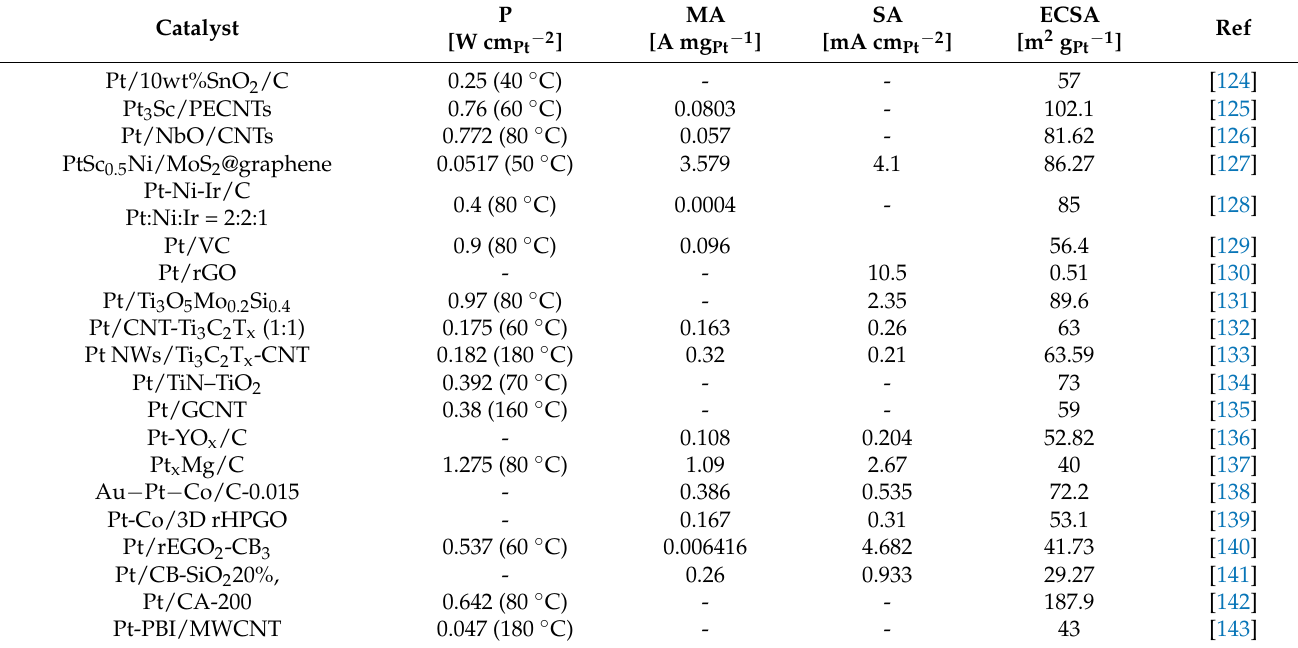
Table 4. Platinum-based catalyst for fuel cells application: Peak power density (P), mass activity (MA), specific activity (SA) and electrochemical active surface areas for selected catalyst for each article